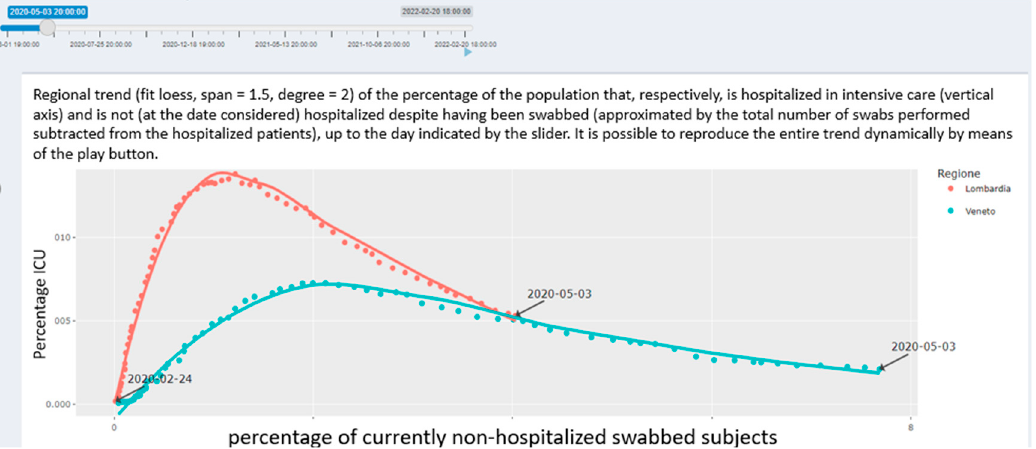
Figure 5. Section for leading indices provided by the COVID-19 pandemic application (web page screenshot). In this reported example, the dynamics across time of the percentage of people tested against the percentage of people admitted to the ICU are displayed for the selected region (in the example shown: Lombardia and Veneto) both as a time-dynamic running graph and as tabular